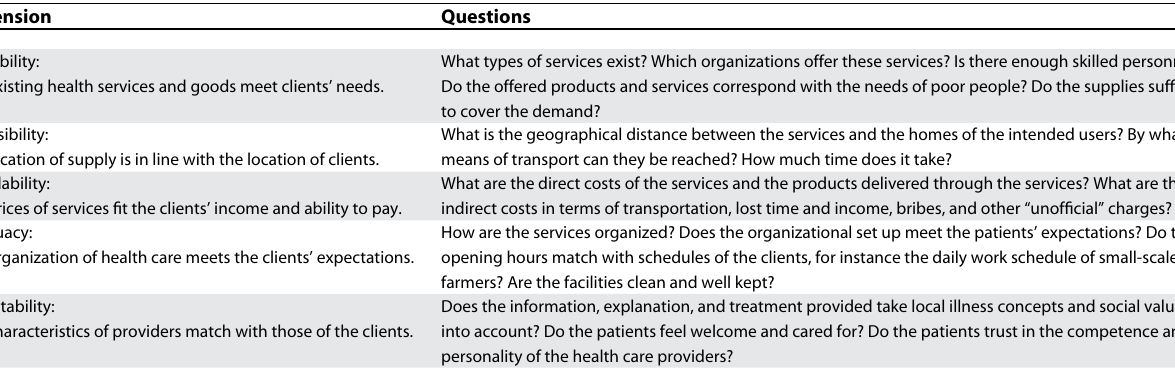
Table 1. Five Dimensions of Access to Health Care Services Dimension